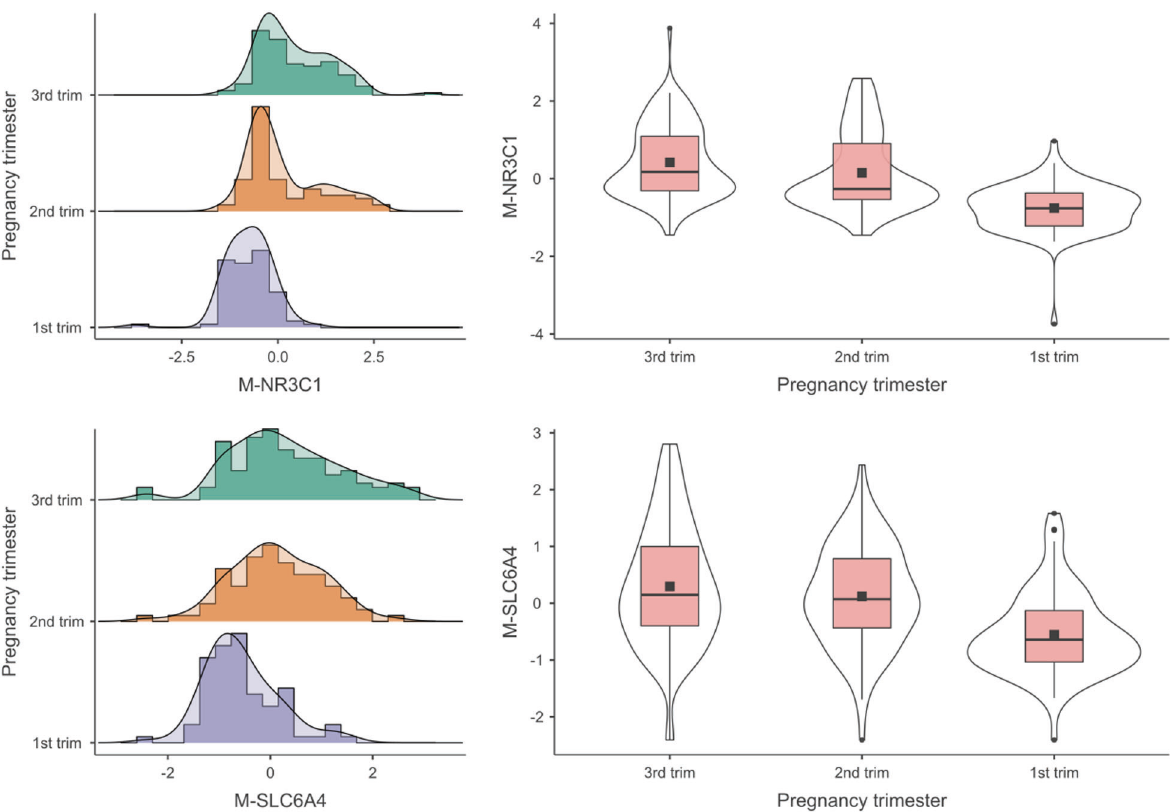
Fig. 2 Maternal SLC6A4 and NR3C1 methylation by pregnancy trimester. Note. *** P <